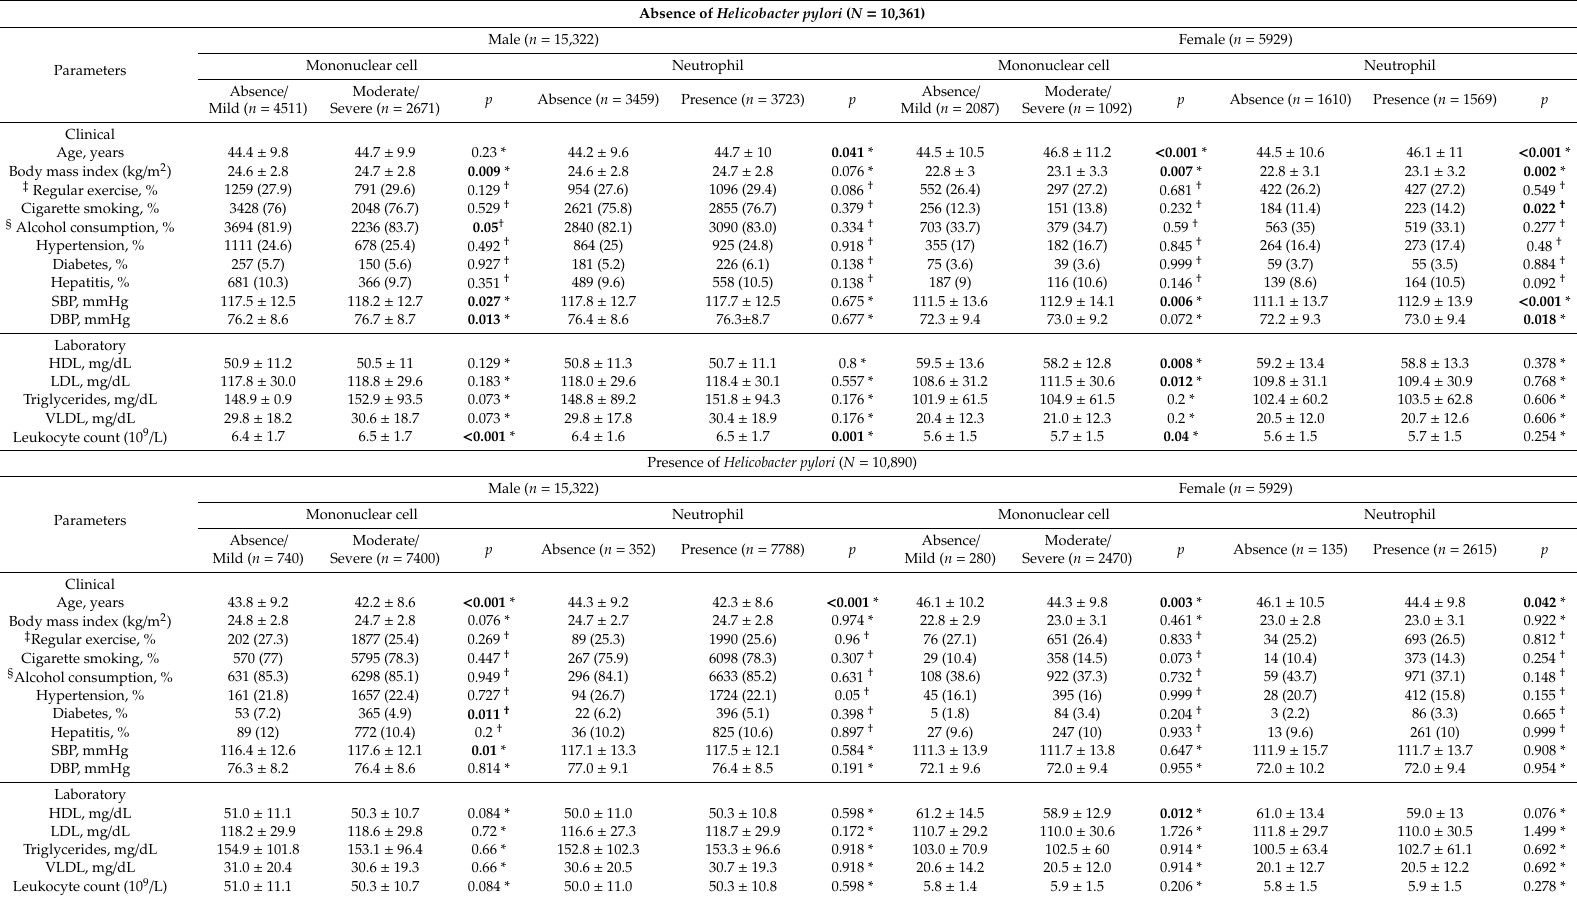
SBP, systolic blood pressure; DBP, diastolic blood pressure; HDL, high-density lipoprotein; LDL, low-density lipoprotein; VLDL, very-low-density lipoprotein; Values are expressed as the mean ± standard deviation or number. * Student’s t -test; † Chi-square test; ‡ Regular exercise is defined as exercising 3 or more days per week; § Alcohol consumption is defined as consuming alcohol at least once per week; p < 0.05 is shown in